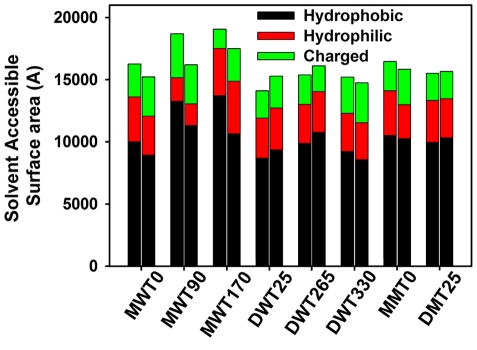
Comparison of solvent accessible surface area of hydrophobic C-terminal residues Ile31-Ala42, charged/hydrophilic N-terminal residues Leu17-Ser26, and turn residues Asn27-Ala30 between the initial 5 ns (left column) and the final 5 ns (right column) trajectories for all globulomers.